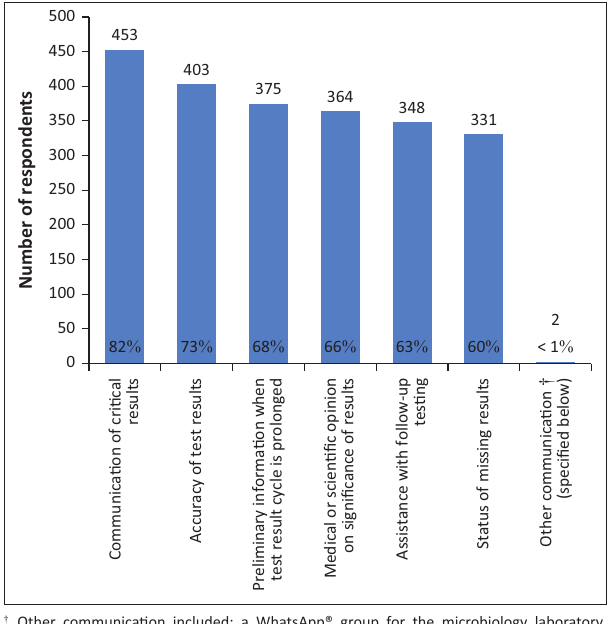
FIGURE 3: Usefulness of laboratory communication/consultation, South Africa, 13 October 2015–13 November 2015.